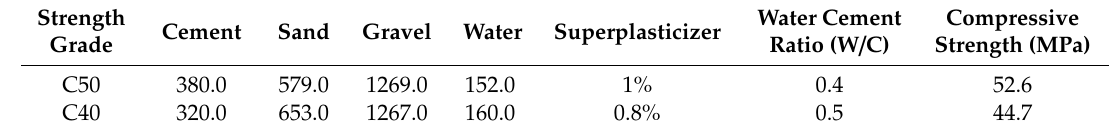
Table 1. Concrete composition [kg · m − 3